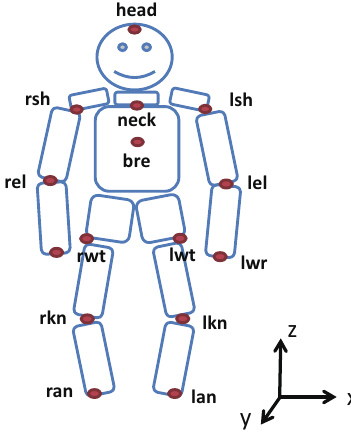
Figure 3: Points used for analysis